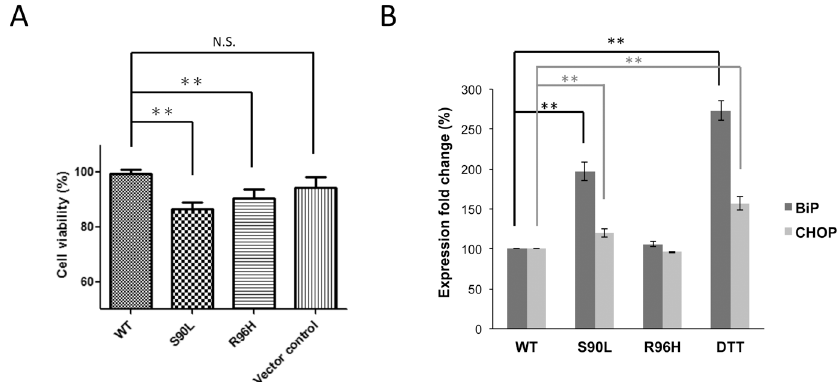
Fig 4. Cell viability and endoplasmic reticulum (ER) stress assays. (A) The Cell counting kit-8 (CCK-8) colorimetric assay revealed that expression of S90L or R96H seipin led to a significant reduction in viability of HEK293 cells. The percentage of the viable cells in HEK293 cells transfected to express wild-type seipin was set as 100% and used for comparison. Values are shown as means ± SEM of 24 independent transfections ( ** , p < 0.01). (B) The activation of ER stress was evaluated by quantitative real-time PCR (qRT-PCR), measuring the expression levels of BIP and CHOP mRNA. Cells exposed to DTT or transfected with S90L seipin expression plasmid represented the positive controls. All values (mean ± SEM, n = 4) were normalized to GAPDH mRNA levels ( ** , p < 0.01). Cells expressing R96H seipin did not have a significantly higher expression levels of BIP or CHOP mRNA compared with cells expressing WT seipin, suggesting that the R96H seipin did not induce ER